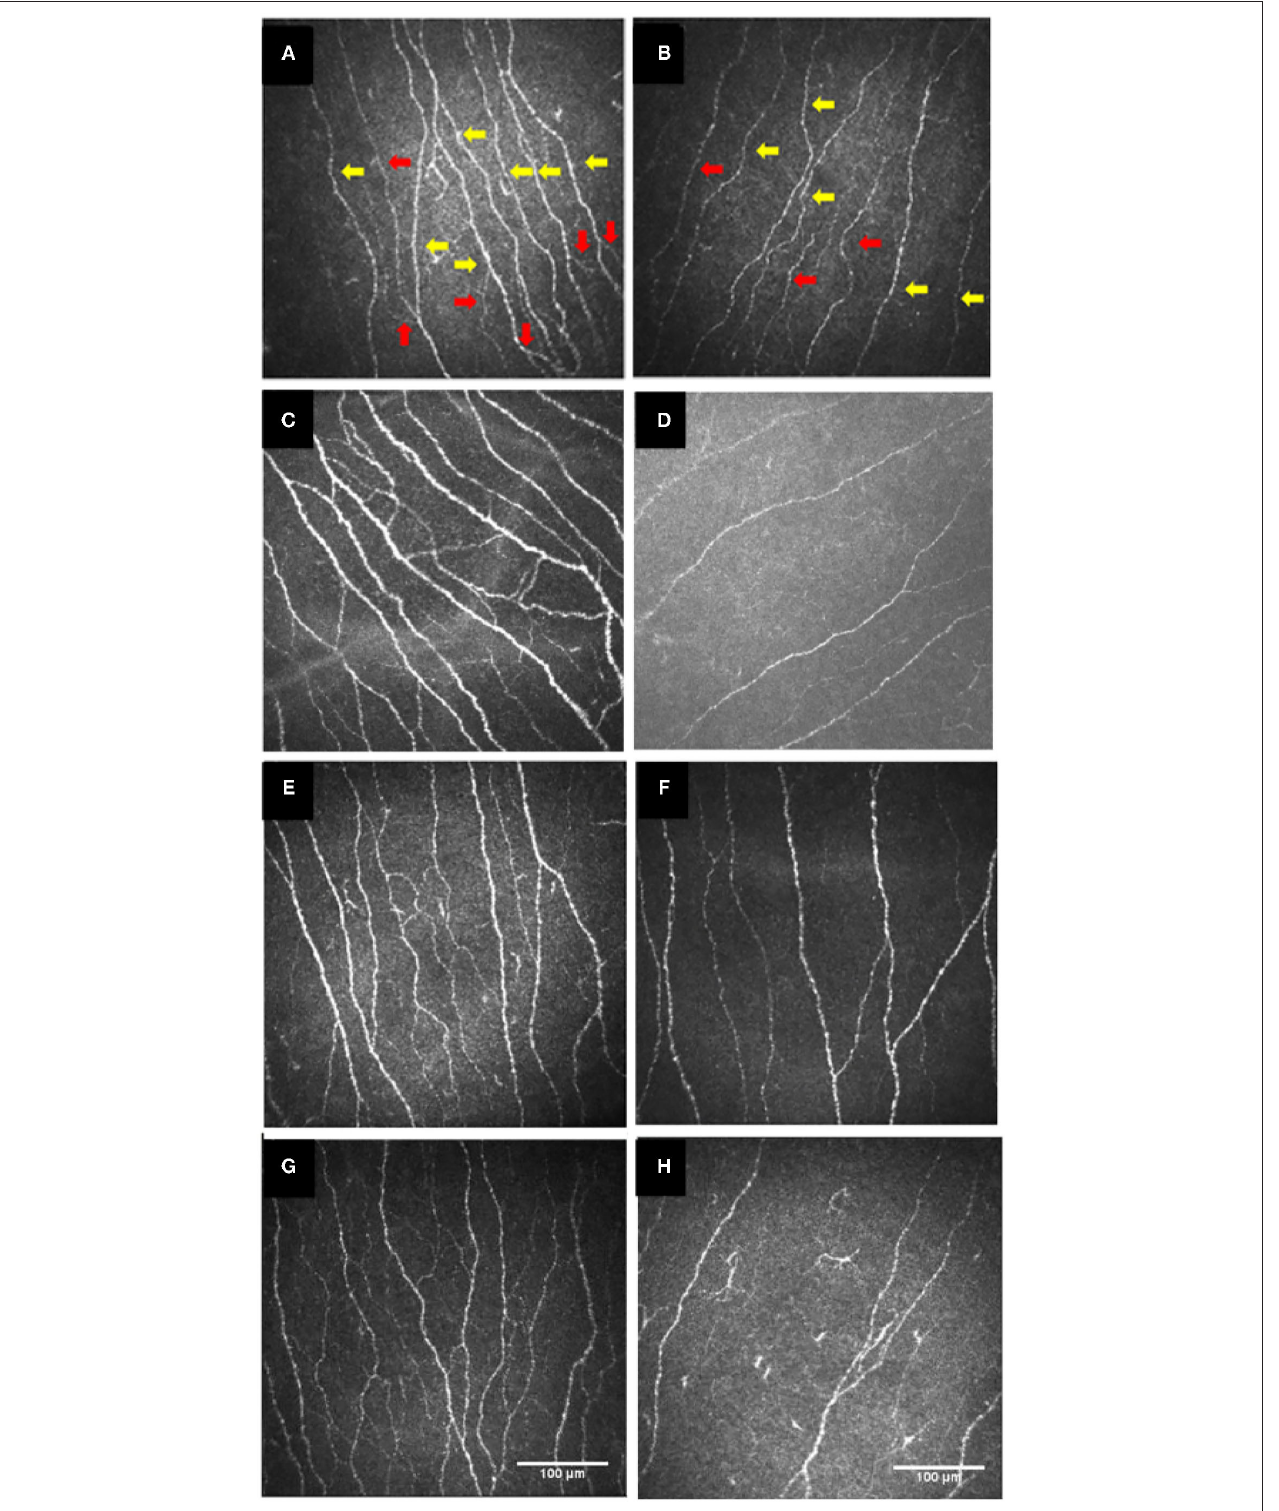
FIGURE 3 | IVCM images of the cornea in the healthy controls (A,C,E,G) and patients with type 1 diabetes (B) , or with Sjögren’s syndrome (D) , or with celiac disease (F) , or with Behçet’s disease (H) . Red arrows show corneal nerve branches and yellow arrows show corneal nerve fibers. (A,B) were re-organized with permission from (45), copyright 2017, Public Library of Science. (C,D) were re-organized with permission from (62), copyright 2021, BioMed Central. (E,F) were re-organized with permission from (33), copyright 2020, Public Library of Science. (G,H) were re-organized with permission from (40), copyright 2018, Frontiers. IVCM, in vivo confocal